Question: Write a caption explaining this figure to a reader.
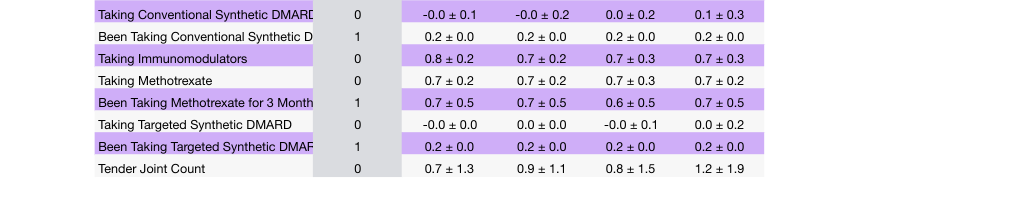
Answer: An example twin record for a single RA patient is shown, which reports the mean and standard deviation of the twins for that patient. A sample of static baseline information is given at the top of the record. A sample of longitudinal outcomes predicted by the model are supplied as rows, with columns indicating the time in months since baseline visit.